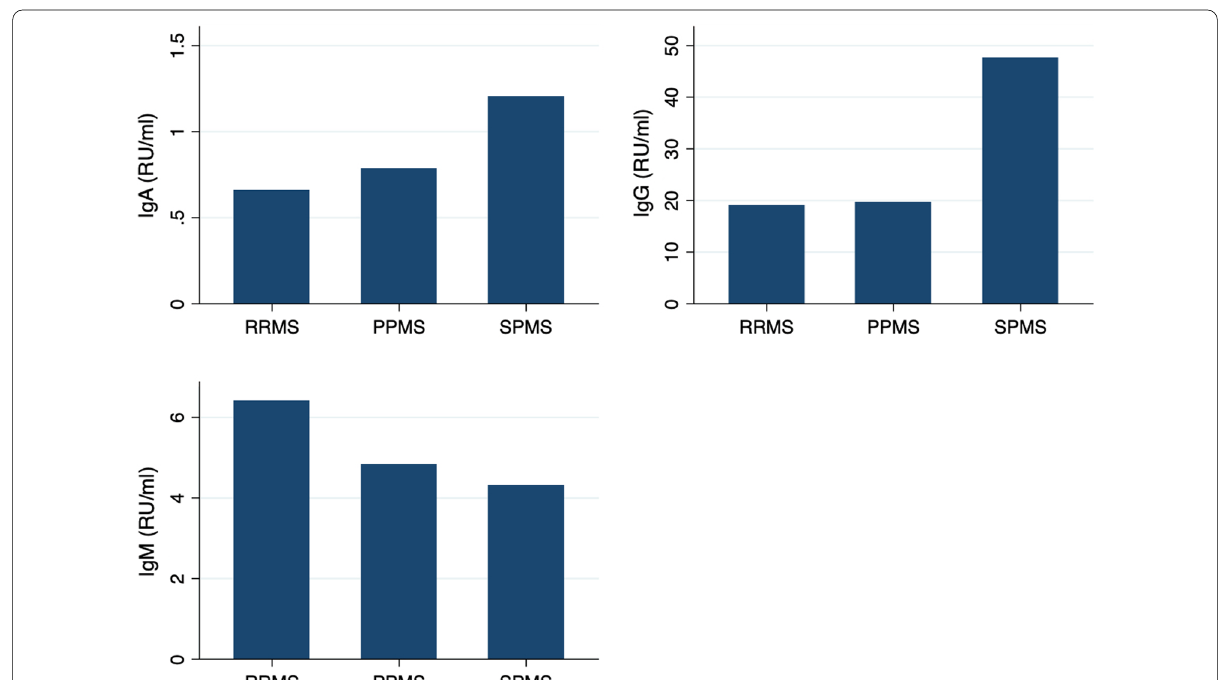
Fig. 1 Comparison of IgA, IgG and IgM titers by type of multiple sclerosis. After multiple comparison correction, a significant difference was observed in anti‑HP IgA concentration between RRMS and SPMS ( 0.54 UR/ml, 95% CI 0.002–1.09). RR/ml relative units per milliliter; RRMS − relapsing–remitting multiple sclerosis; PPMS primary‑progressive multiple sclerosis; SPMS secondary‑progressive multiple